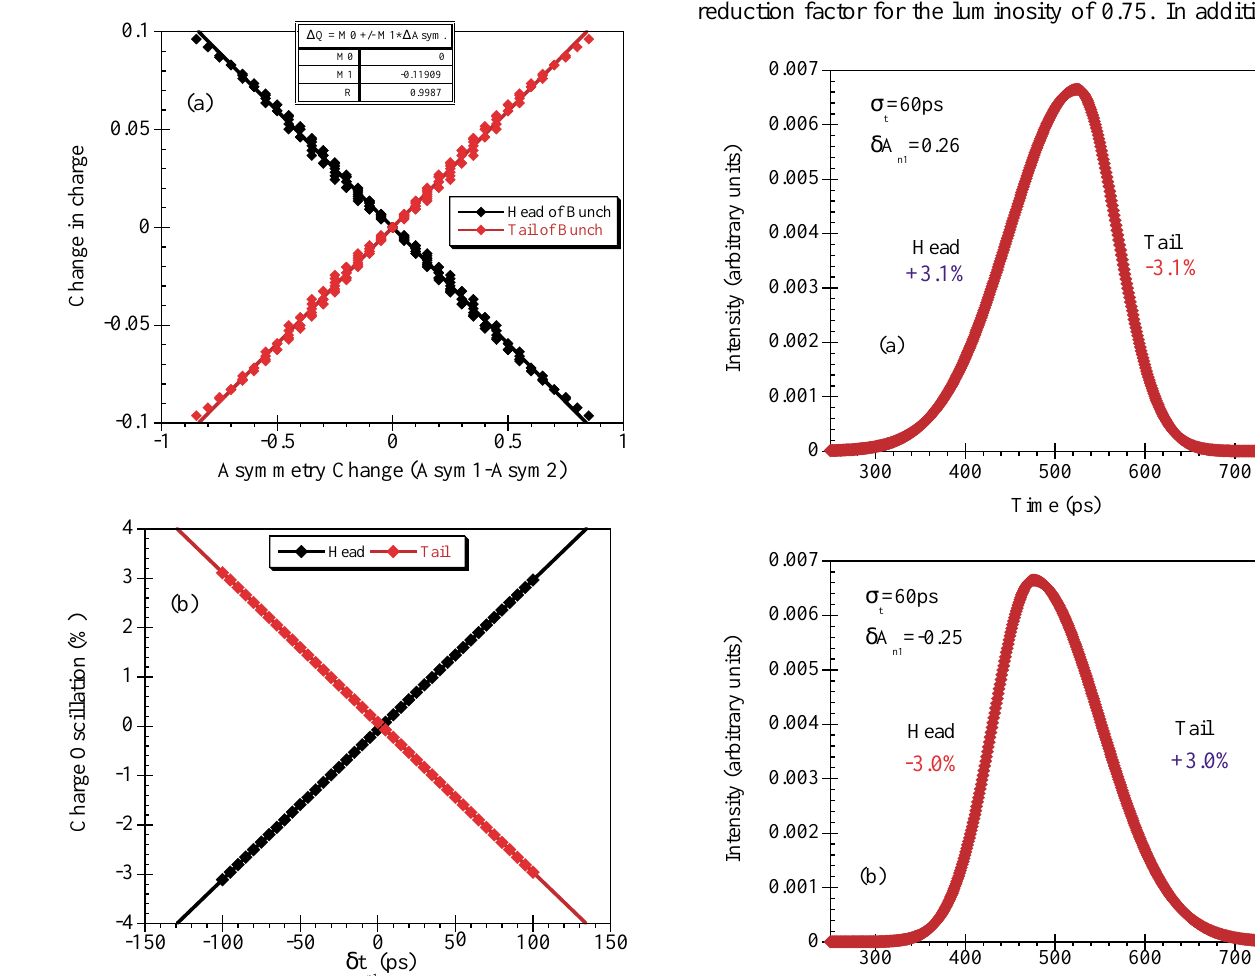
FIG. 20. (Color) (a) The degree of breathing due to an asymme- try factor deviation between two distributions. (b) The degree of breathing in a distribution due to a time oscillation from the lead bunch in a train.